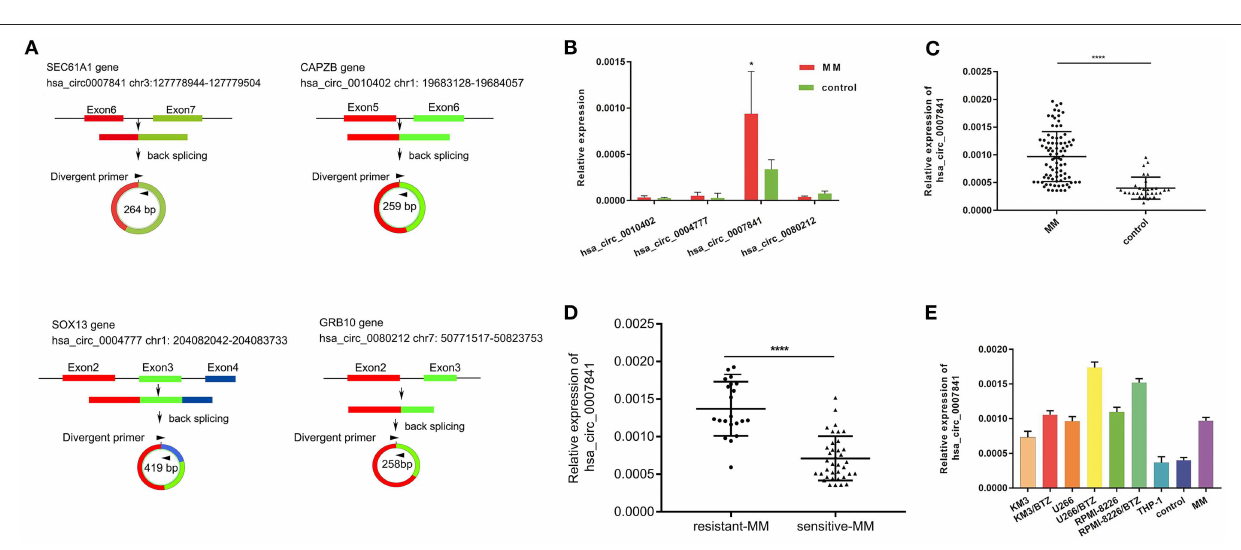
FIGURE 2 | Differentially expressed circRNAs. (A) Key circRNAs are circulated by exons. (B) qRT-PCR verification of four circRNAs in MM patients and controls. (C) Expression of hsa_circ_0007841 in the bone marrow of 86MM patients and 30 controls. (D) Expression of hsa_circ_0007841 in bortezomib (BTZ) sensitive ( N = 36) and bortezomib (BTZ) resistant ( N = 21) patients. (E) Expression of hsa_circ_0007841 in MM patients, cell lines, and controls. MM, multiple myeloma; qRT-PCR, Real-time quantitative polymerase chain reaction. * P < 0.05, **** P <